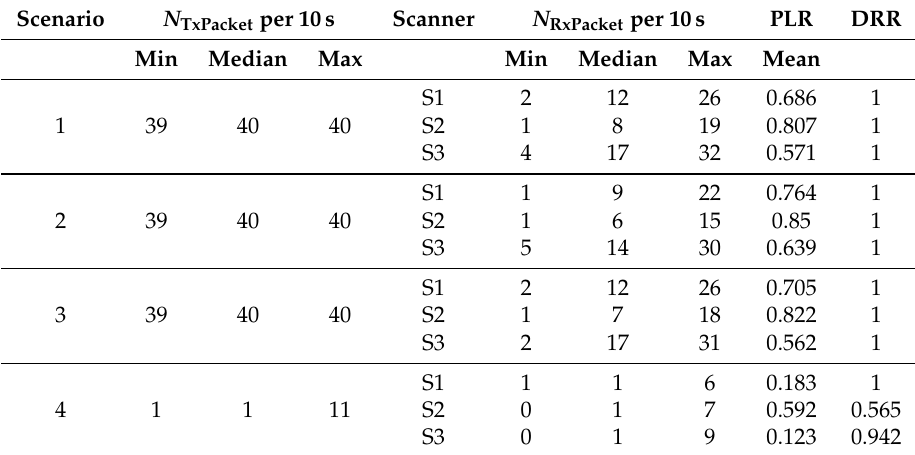
Table 5. Statistics of ADV packets transmitted from the monitored node and received by scanners in different scenarios. PLR and DRR values are calculated for the monitored node. Scenario N TxPacket per 10s Scanner N RxPacket per 10s